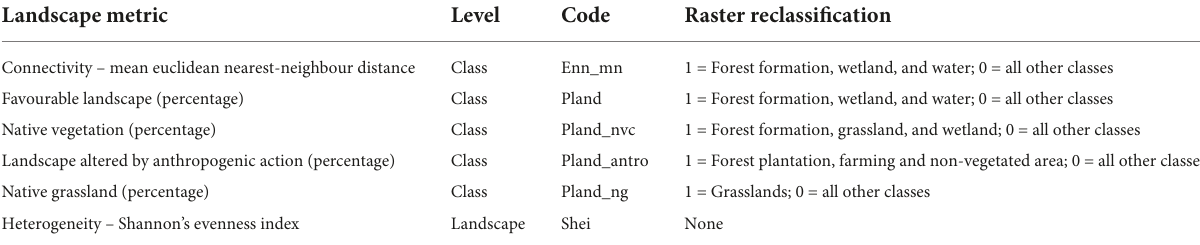
TABLE 1 Selected landscape metrics and respective level, code and raster reclassification, for bat acoustic sampled during the spring and summer of 2019 and 2020 in the Brazilian Pampa. Landscape metric Level Code Raster